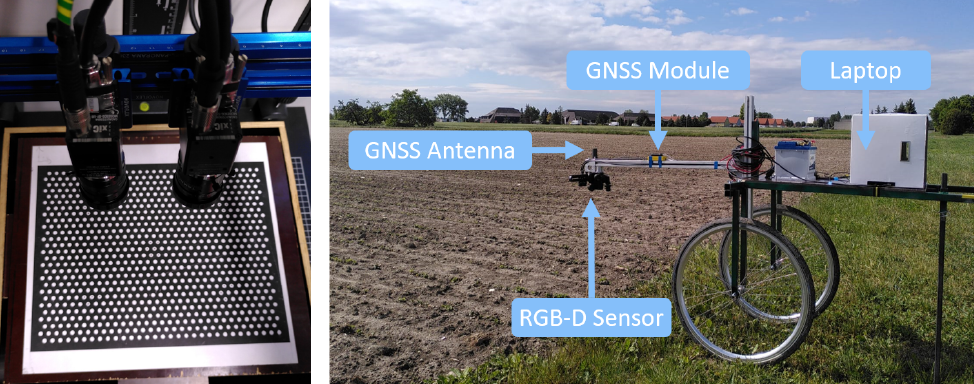
Figure 1. RGB-D sensor with calibration target ( left ) and measurements trolley equipped with sensors on the field ( right